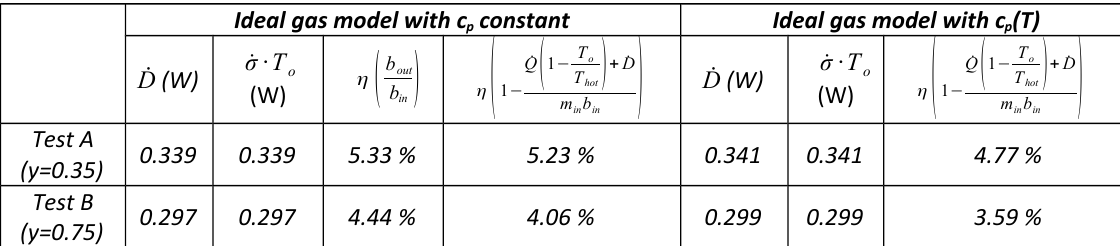
Table 6. Check of the Gouy-Stodola relationship and the exergetic efficiency